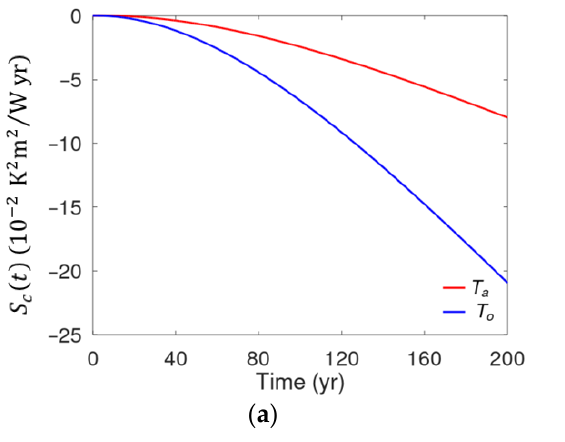
Figure 7. Sensitivities of global mean surface temperature (red line) and global mean deep ocean temperature (blue line) with respect to parameter C o , calculated for linear forcing: ( a ) over time interval of 0–200 years, ( b ) over time interval of 0–2000 years.